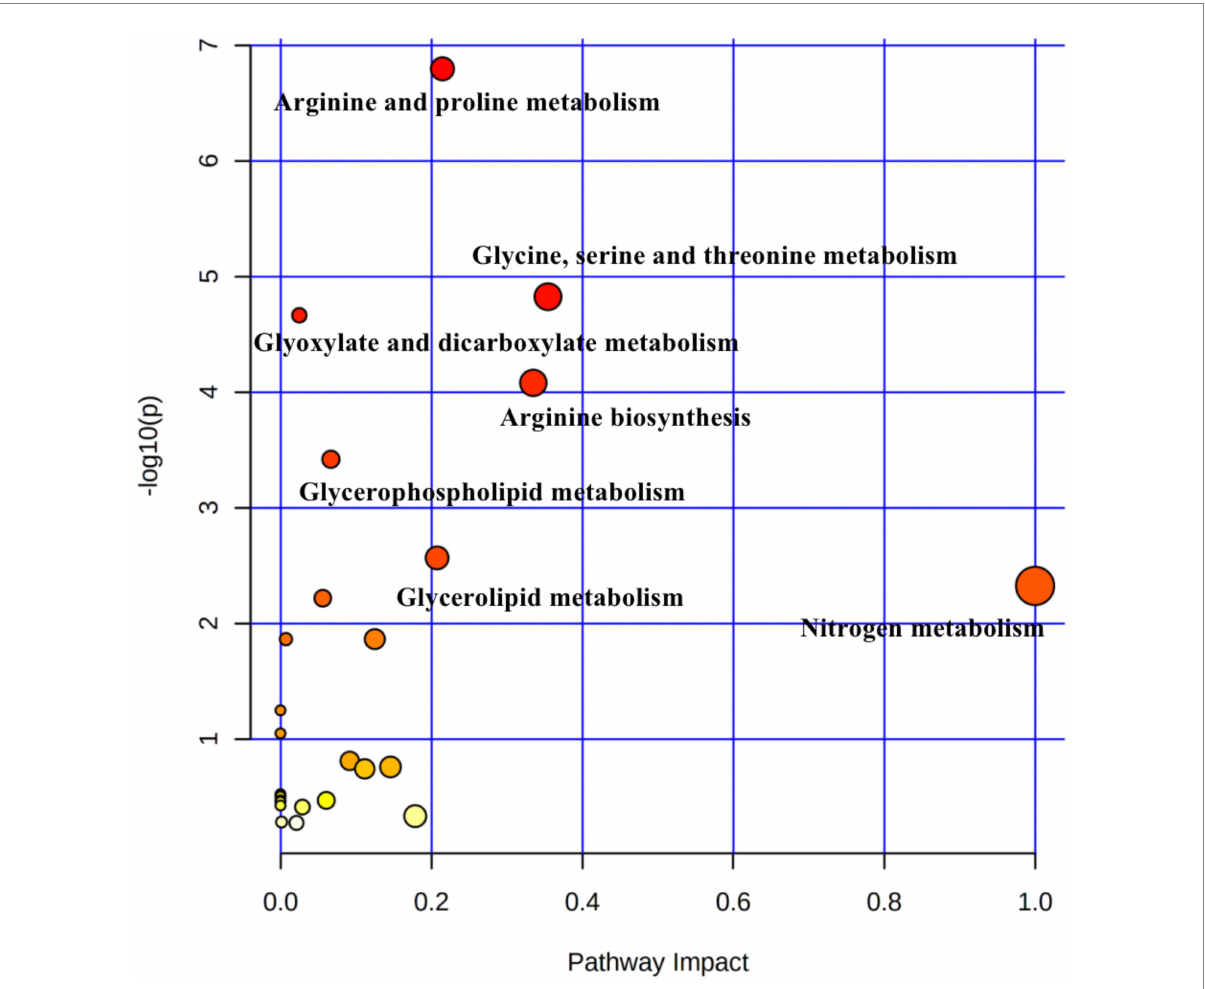
FIGURE 4 Pathway analysis of differential metabolites in rumen samples from yaks with different dietary concentrate ratios using the Bos taurus Kyoto Encyclopedia of Genes and Genomes (KEGG) database of MetaboAnalyst 4.0. Larger circles indicate richer pathways and darker colors indicate higher pathway impact values. The closer the color is to red, the smaller the p